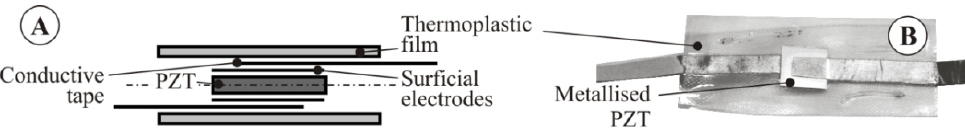
Figure 7. Prototypic thermoplastic ‐ compatible piezoceramic modules (TPM) configuration. ( A ) Built up; ( B ) Consolidated TPM (d 31 mode).